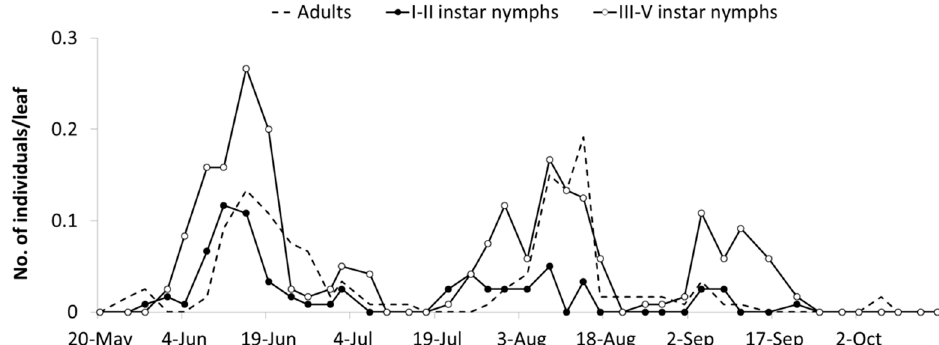
Figure 5. Seasonal abundance of Erasmoneura vulnerata nymphs and adults observed on leaves of potted plants placed 100 m far from A2 area (B2 area, 2009).